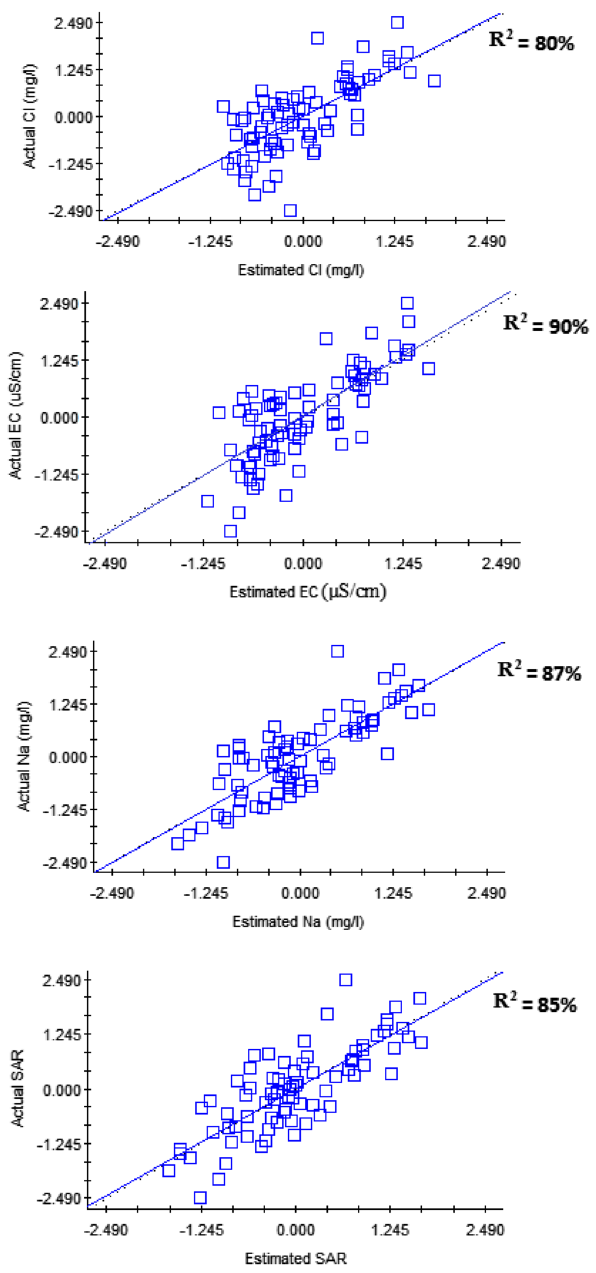
Fig. 3 Cross validation results of the parameters showing the esti- mated values versus actual values